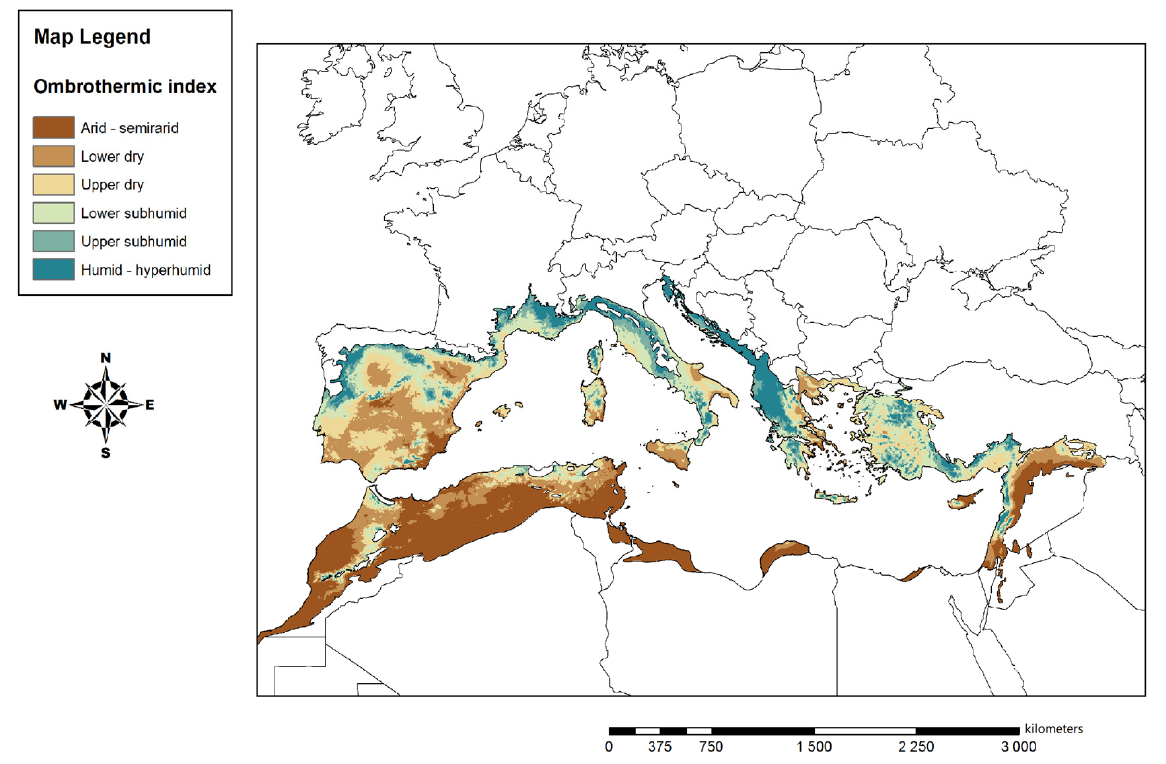
Figure 2. Map of ombrotypes in the Mediterranean Basin. The optimum ombrotype for olive cultivation is the dry-subhumid. Geographic Coordinates Mediterranean Basin: 38 ◦ N 17 ◦ E.